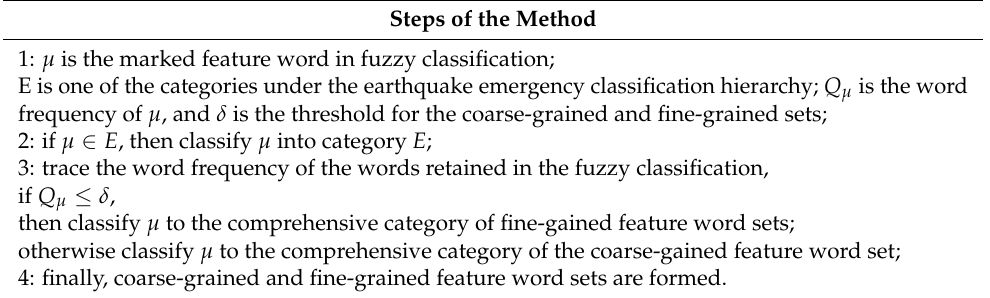
Table 4. The proposed method for fuzzy classification feature word set processing. Steps of the